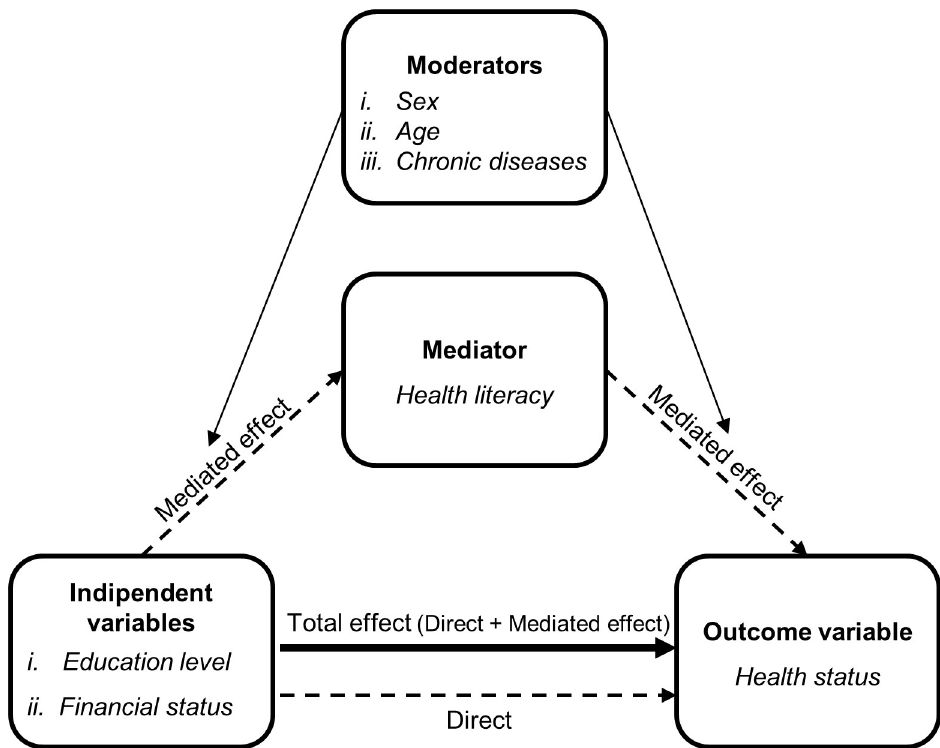
Fig 1. Conceptual model of health literacy as a mediator of the association between socio-economic factors and health status.